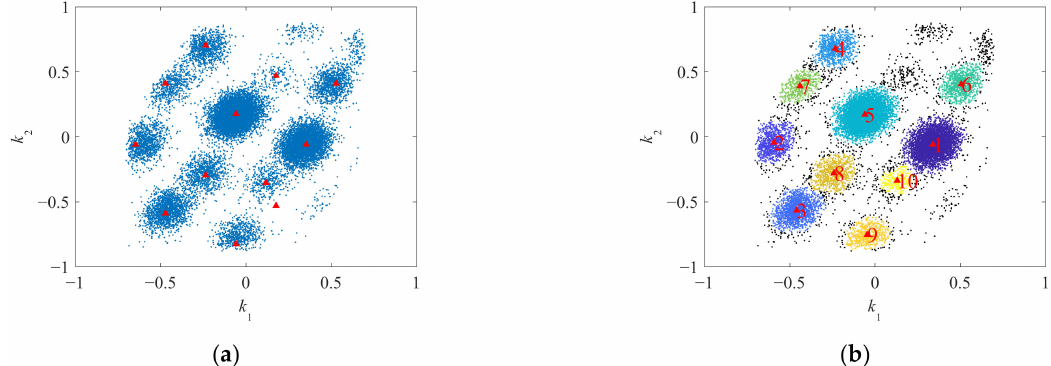
Figure 6. The clustering results. ( a ) Theoretical cluster center. ( b ) The clustering